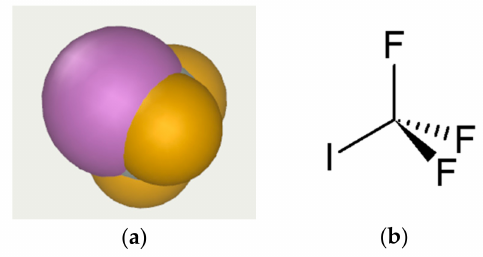
Figure 2. Topology ( a ) and formulation ( b ) of